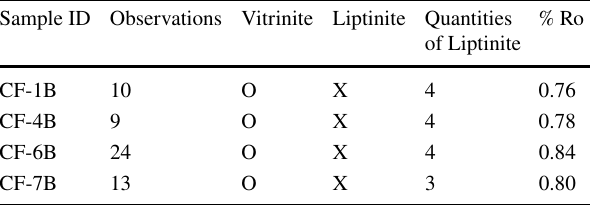
Table 5 Organic petrographic results of samples from Chichali For-